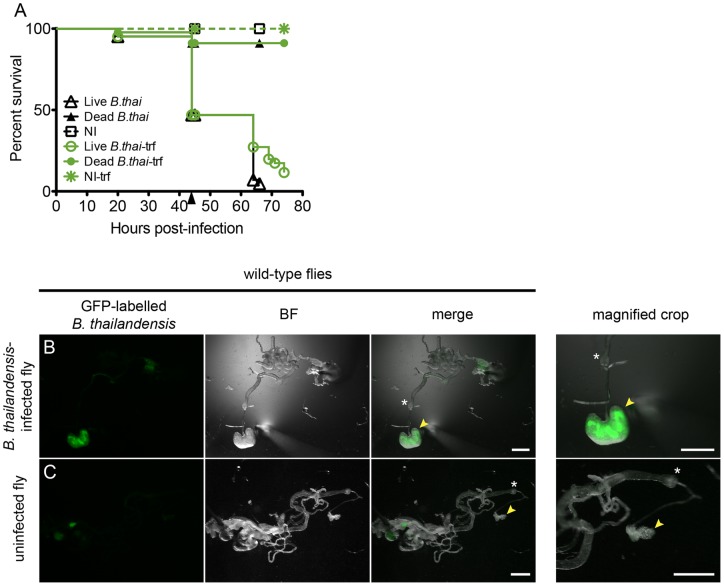
WT flies fed B. thailandensis-infected food are killed and have enlarged crop.(A) Survival of WT flies on infected food at 25°C. Flies kept on infected food died within 3.5 days after they were placed on this food. Second set of flies (trf) was kept on infected food and transferred to normal food, free of bacteria, at 44 hr (black arrowhead). The survival of the tranferred flies was slightly increased in comparison to the non-transferred group, but this difference was not significant. Controls were fed either food containing heat-killed B. thailandensis or no bacterium. The survival of the control groups was not affected. Sample size was at least 40 flies per condition. (B) Dissected gut of WT male D. melanogaster fed food infected with GFP-labelled B. thailandensis. The presence of the bacteria in the crop is confirmed by green fluorescence, which is visible only in the infected flies. (C) An uninfected control had a smaller crop. The crops of the infected and uninfected flies are shown at a higher magnification [magnified crop]. At least 3 flies were imaged per condition. Yellow arrowheads point to crop; white asterisks mark the proventriculus. Scale bars represent 500 µm.